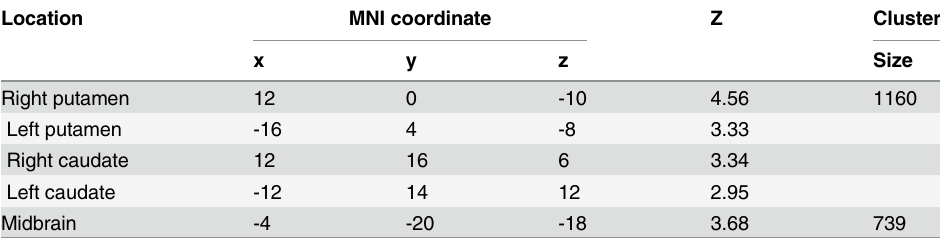
Table 2. Brain areas positively correlated with the actual winning